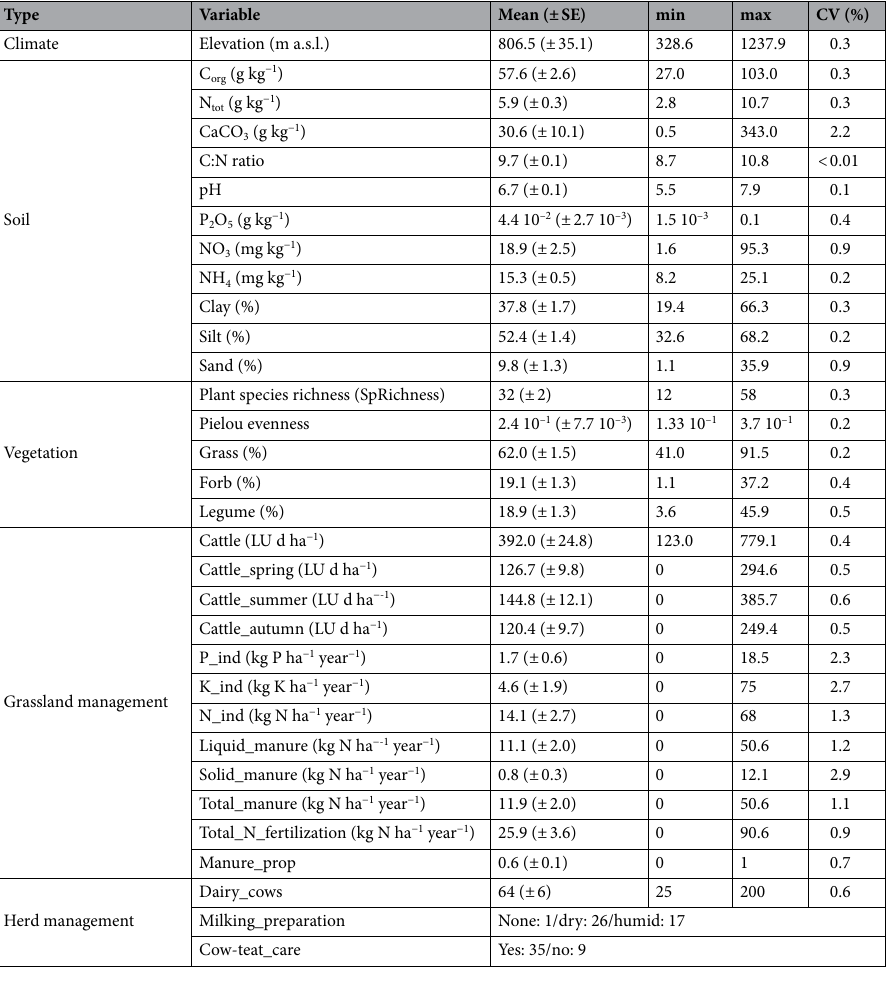
Table 1. Summary statistics of environmental conditions and grassland and herd management. C org : Soil organic carbon content (g kg −1 ); N tot : Total soil nitrogen content (g kg −1 ); CaCO 3 : Soil carbonate content (g kg −1 ); C:N ratio: Soil organic carbon to nitrogen ratio; pH: Soil pH in water; P 2 O 5 : Soil phosphate content (g kg −1 ); NO 3 : Soil nitrate content (mg kg −1 ); NH 4 : Soil ammonium content (mg kg −1 ); Clay: Clay content (g kg −1 ); Silt: Silt content (g kg −1 ); Sand: Sand content (g kg −1 ); Grass: relative cover of grasses (graminoids) in the plant community (%); Forb: relative cover of forbs in the plant community (%); Legume: relative cover of legumes in the plant community (%); Cattle: Annual grazing pressure expressed in livestock units equivalent day per hectare (LU d ha −1 ); Cattle_spring: Spring grazing pressure expressed in livestock units day per hectare (LU d ha −1 ); Cattle_summer: Summer grazing pressure expressed in livestock units day per hectare (LU d ha −1 ); Cattle_autumn; Autumn grazing pressure expressed in livestock units day per hectare (LU d ha −1 ); P_ind: Annual P fertilization by means of industrial fertilizers (kg P ha −1 year −1 ); K_ind: Annual K fertilization by means of industrial fertilizers (kg K ha −1 year −1 ); N_ind: Annual N fertilization by means of industrial fertilizers (kg N ha −1 year −1 ); Liquid manure: Annual N fertilization by means of liquid manure (kg N ha −1 year −1 ); Solid manure: Annual N fertilization by means of solid manure (kg N ha −1 year −1 ); Total manure: Annual N fertilization by means of manure (kg N ha −1 year −1 ); Total N fertilization: Sum of annual nitrogen fertilization by means of industrial fertilizers and manure (kg N ha −1 year −1 ); Manure prop: proportion of manure in total annual nitrogen fertilization; dairy cows: Number of dairy cows in the farm; milking preparation: preparation of cow-teat before milking; cow-teat care: protection of cow-teat after milking. Sample size: n =